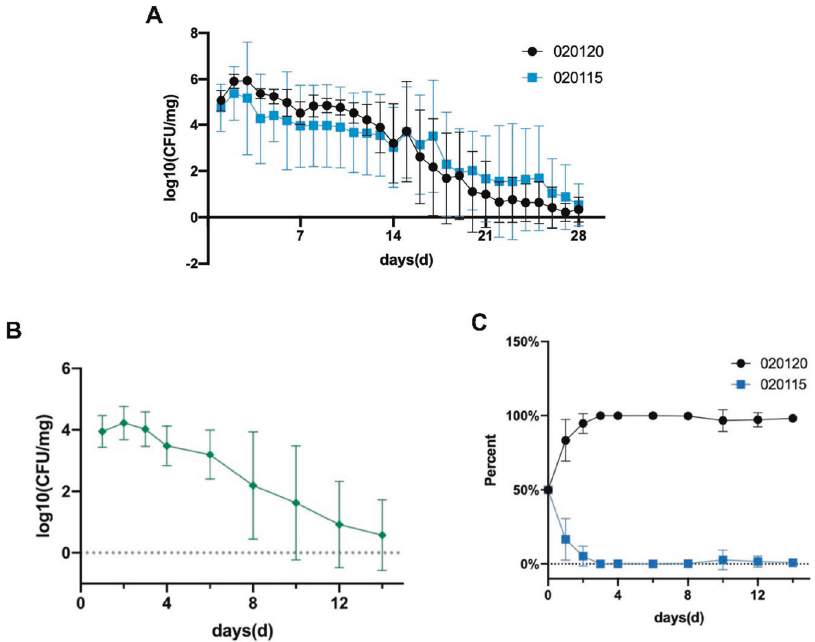
Fig. 5 Murine intestinal colonization by C1_020120, C2_020115, and two strains in combination. A bacterial densities and the colonization days of fecal samples of mice fed with C1_020120 or C2_020115 alone. B bacterial densities and the colonization days of fecal samples of mice co-fed with C1_020120 and C2_020115 in combination. C the proportion of C1_020120 and C2_020115 in fecal samples of mice co-fed with C1_020120 and C2_020115 in